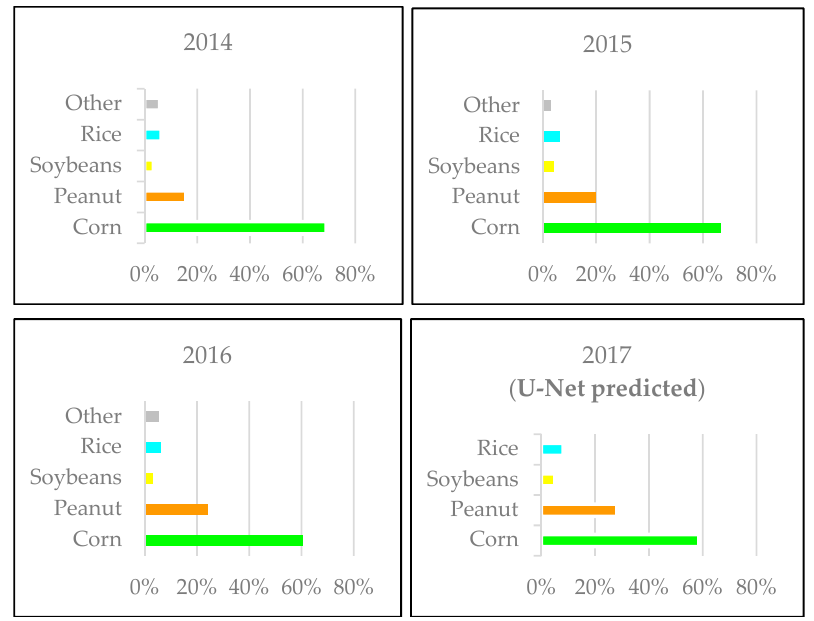
Figure 10. The distribution of the crop types of statistics in 2014–2016 and U-Net predicted result in 2017. The statistics were obtained from Statistic Bureau of Jilin Province (http://tjj.jl.gov.cn/).